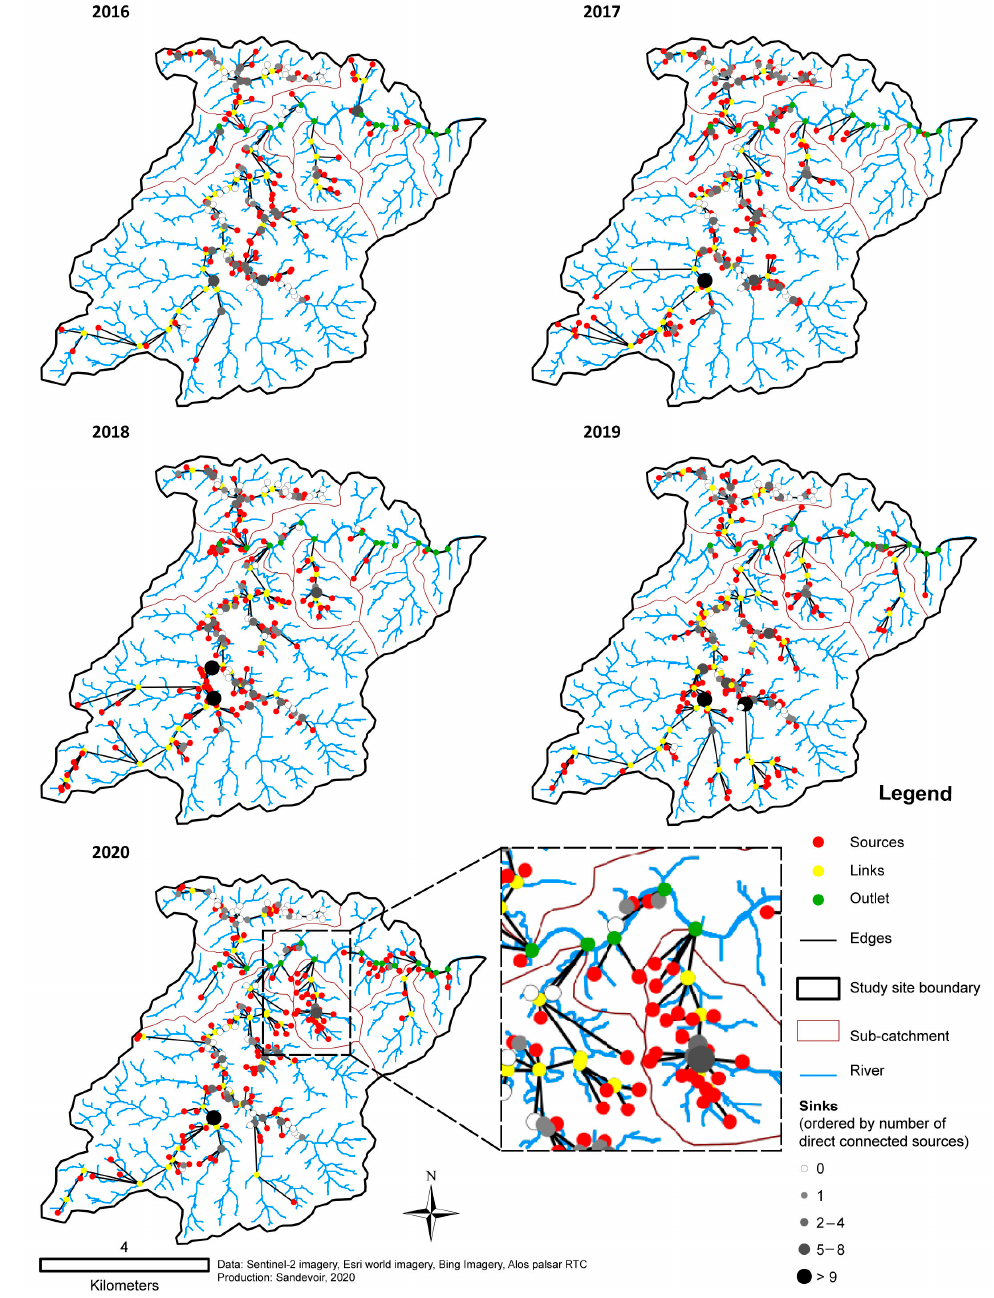
Figure 13. Structural connectivity and graph modelling for sediment and pesticide transfers since